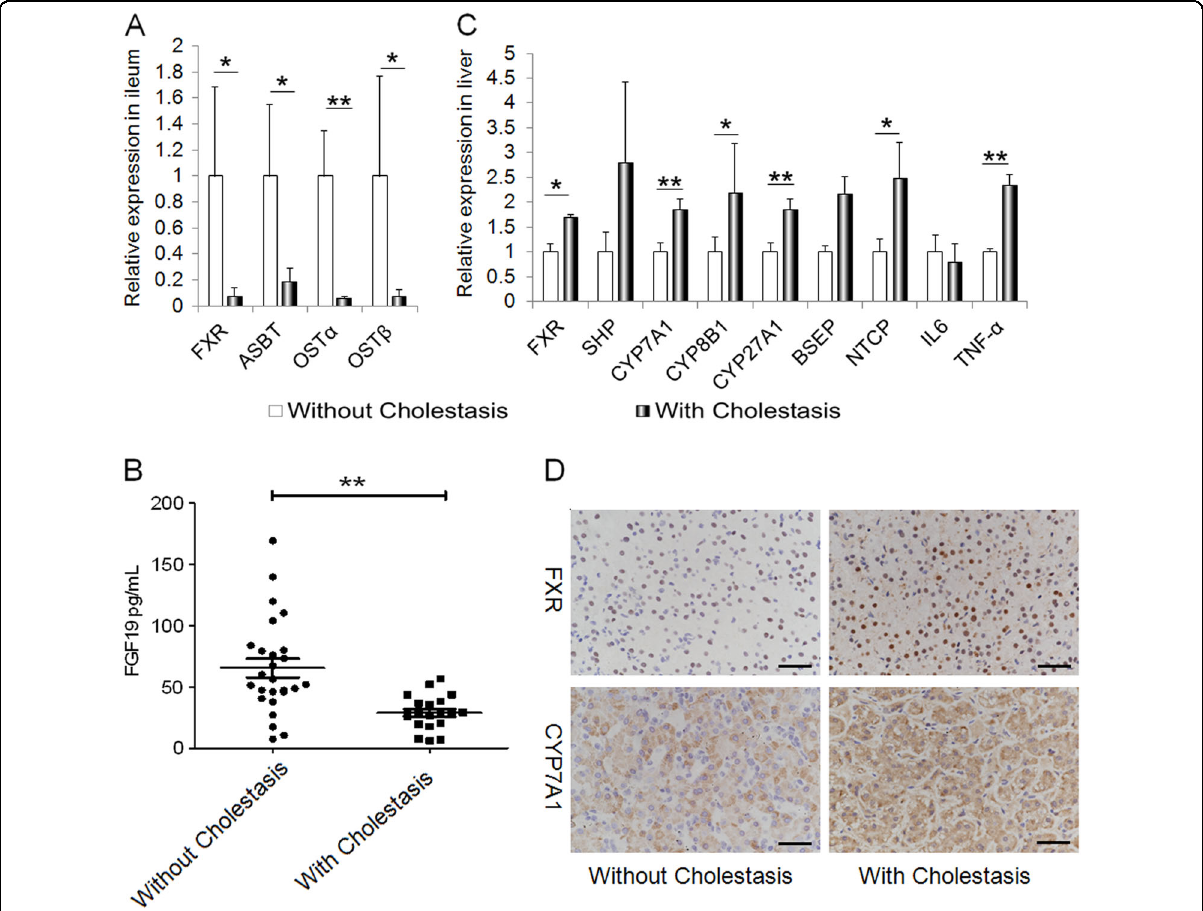
Fig. 2 Intestinal failure (IF) patients with cholestasis exhibit disrupted FXR signaling. a The expression of FXR and its target genes in the ileum was signi fi cantly lower in patients with cholestasis ( n = 12) than in subjects without cholestasis ( n = 8). b Serum FGF19 decreased in patients with cholestasis ( n = 26) compared to those without cholestasis ( n = 20). c Alterations in the expression of FXR and downstream genes in liver tissues (without cholestasis, n = 16, with cholestasis, n = 12). d Representative images of FXR and CYP7A1 immunohistochemical staining in liver tissues of patients. Scale bar = 25 µm; * p < 0.05, ** p <